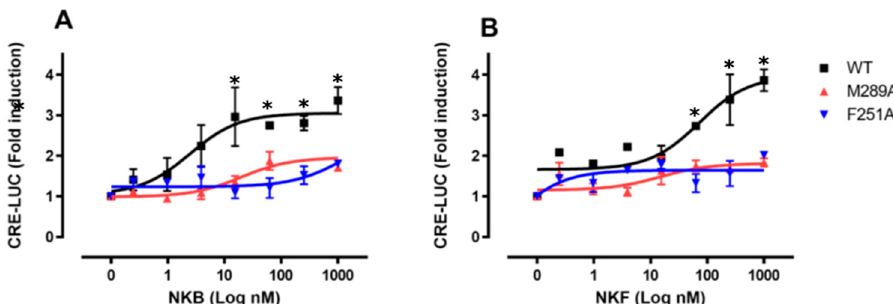
EC50 (nM), minimal effective dose (nM) and maximal effect (Luc fold activation) for the native ti- lapia Tac3Ra and for the Tac3Ra mutants, F251A and M289A. EC50 values and minimal effective doses were calculated when maximal effect (Luc fold activation) was >2.0. (Data from Figure 4).